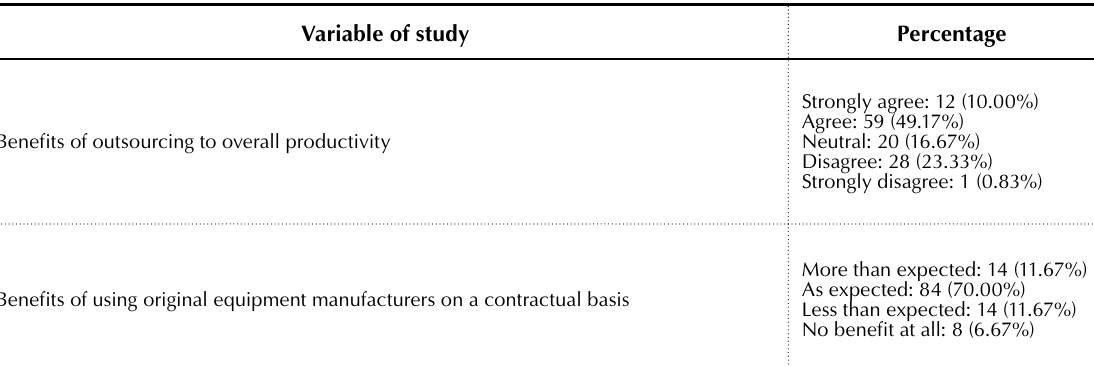
Table 3. Benefits of outsourcing to productivity (n =